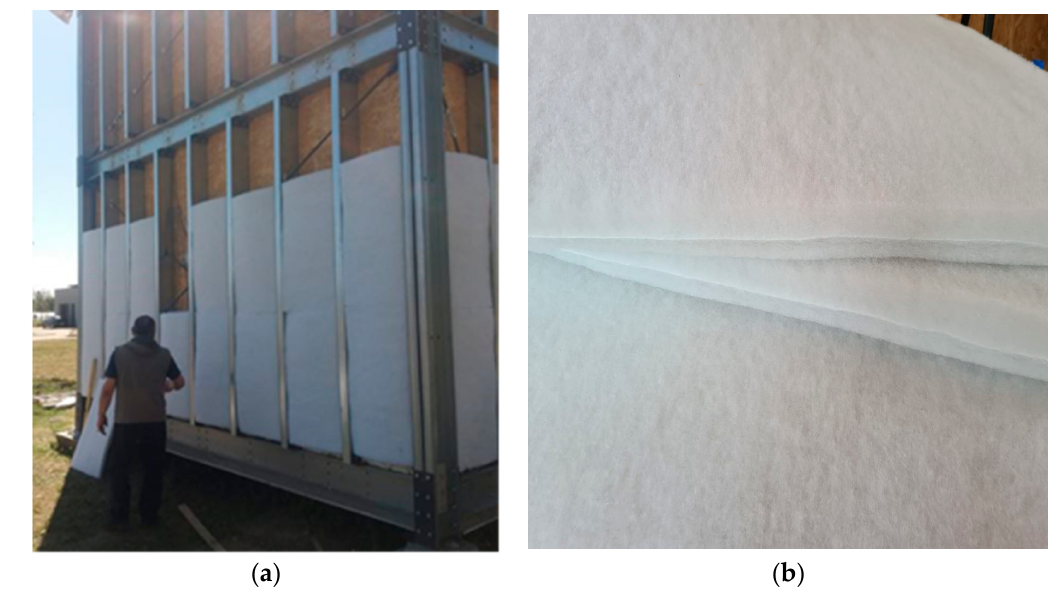
Figure 9. Recycled ‐ PET thermal wadding: ( a ) installation phase at the construction site; ( b ) layers of insulation before installation.